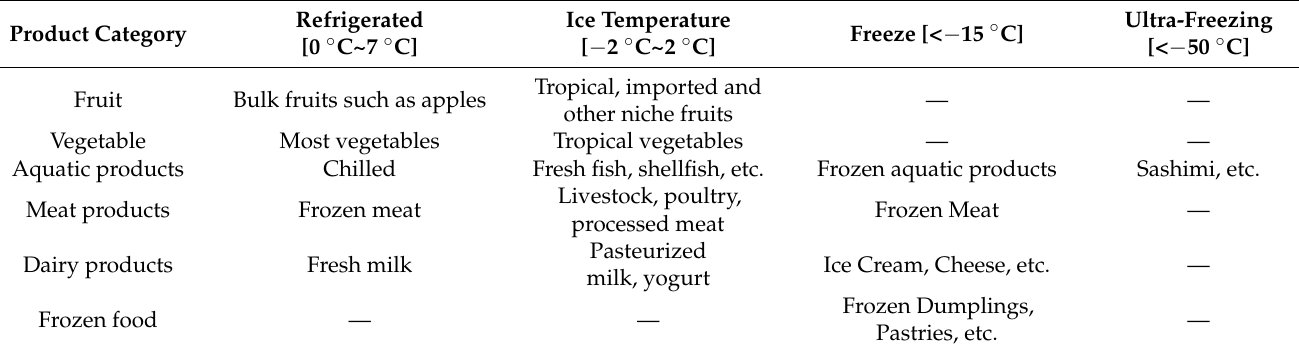
Table 3. The food subdivisions under different cold chain